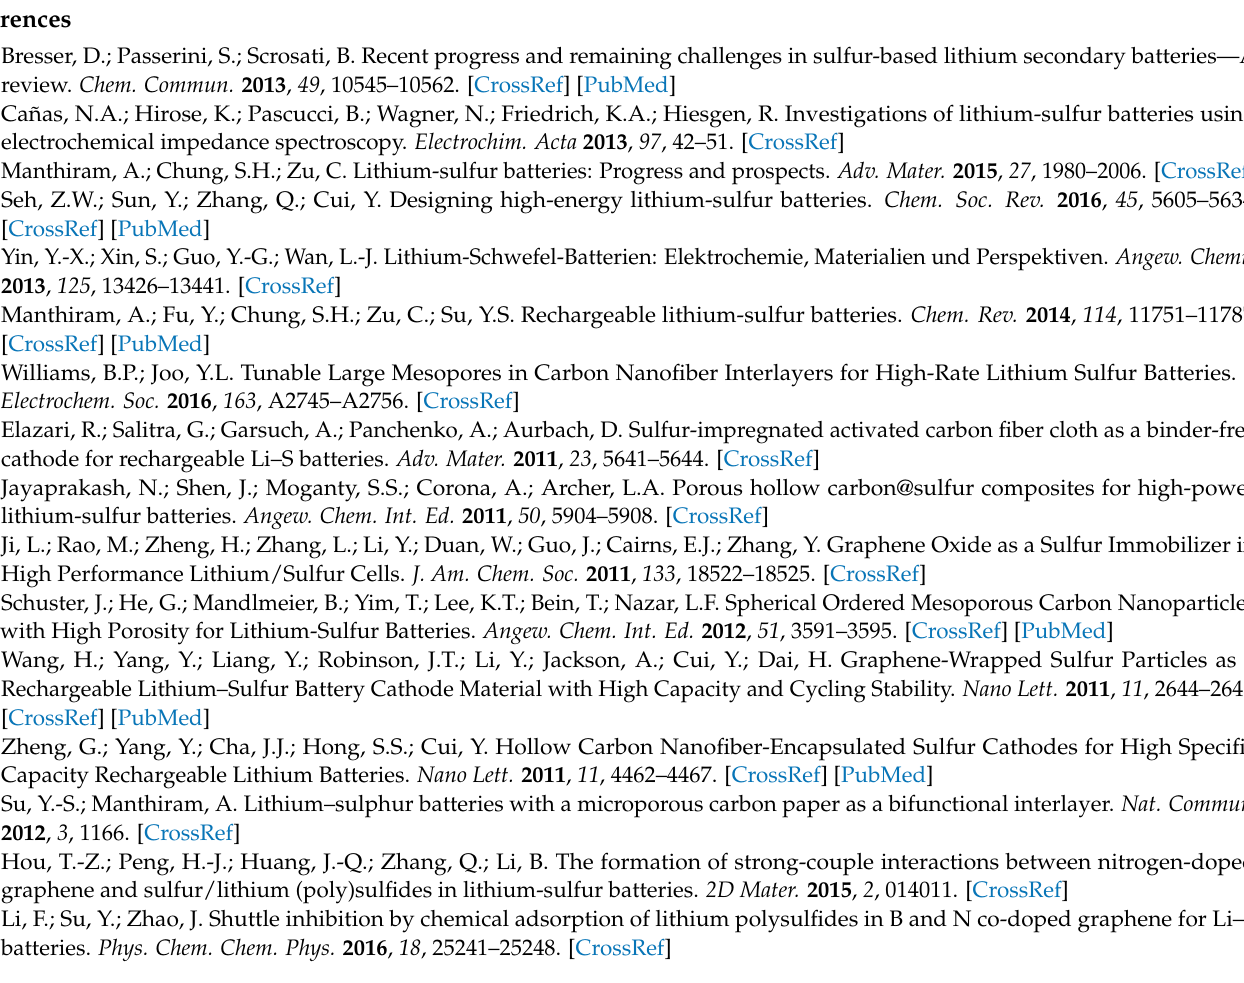
son of systems using CPAN as cathode at 1.7 mg/cm 2 S-loading, Figure S5; EIS Spectra of fresh cells (a) mpCNF-mpCNF and mpCNF-CPAN (b) CPAN-mpCNF and CPAN-CPAN EIS Spectra of discharged cells after 100 cycles (c) mpCNF-CPAN and CPAN-mpCNF, (d) mpCNF-mpCNF and CPAN-CPAN, Figure S6: High Resolution S 2p spectra of (a) mpCNF cathode (b) CPAN cathode (c) mpCNF interlayer (d) CPAN interlayer, Figure S7: High Resolution N 1s spectra of (a) CPAN interlayer (b) CPAN